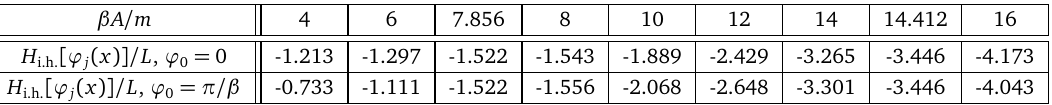
Table B.1: Energies of the two configurations ϕ m σ = 4 / 9 and (cid:96) = mL = 20.